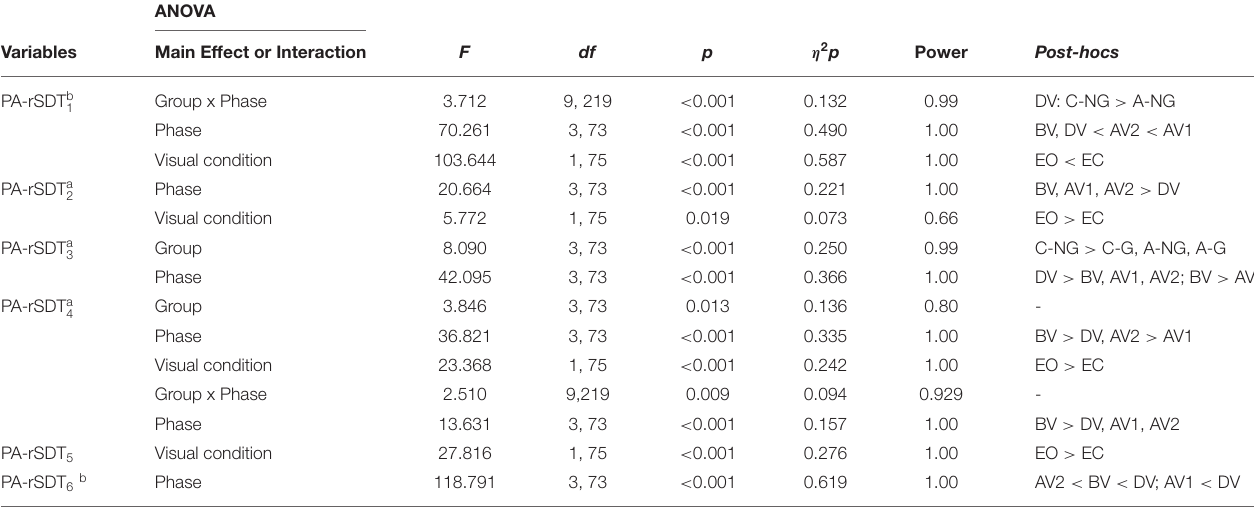
TABLE 4 | Significant results from the four (Group) x four (Phase) x two (Visual condition) ANOVAs in the principal accelerations (PA).